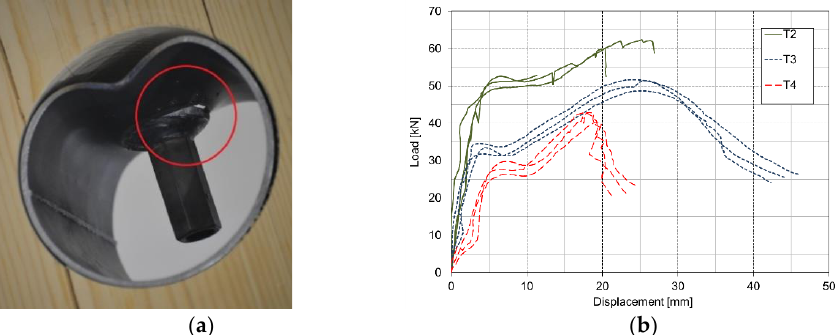
Figure 8. Steel tube HD: ( a ) typical failure (photo credit: Johannes Schneider, reprinted with permis- sion); ( b ) load – displacement curves.